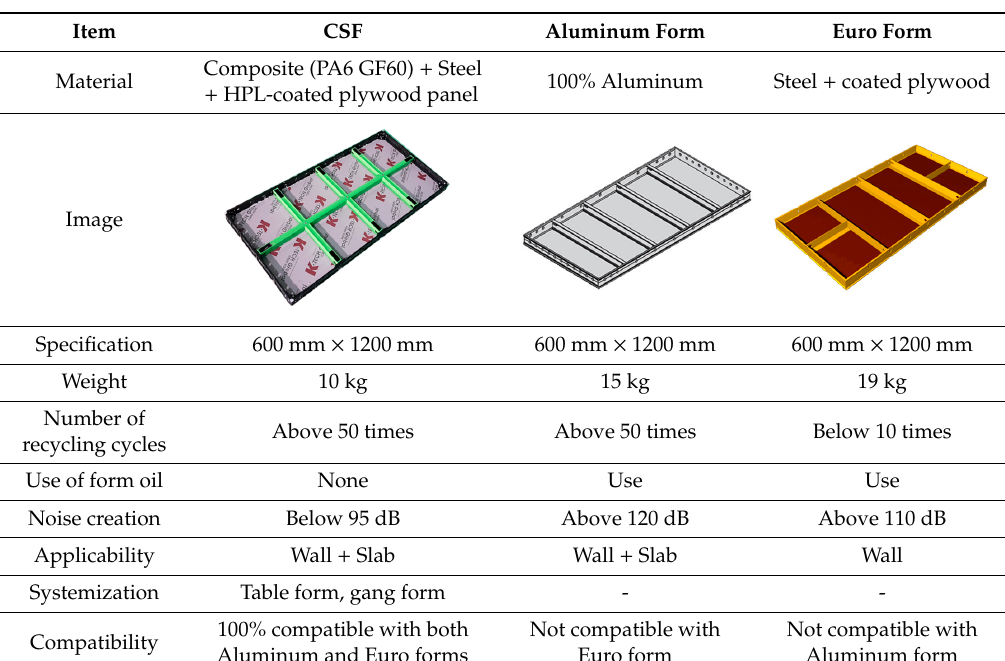
Table 8. Comparison of characteristics of the CSF and existing forms.